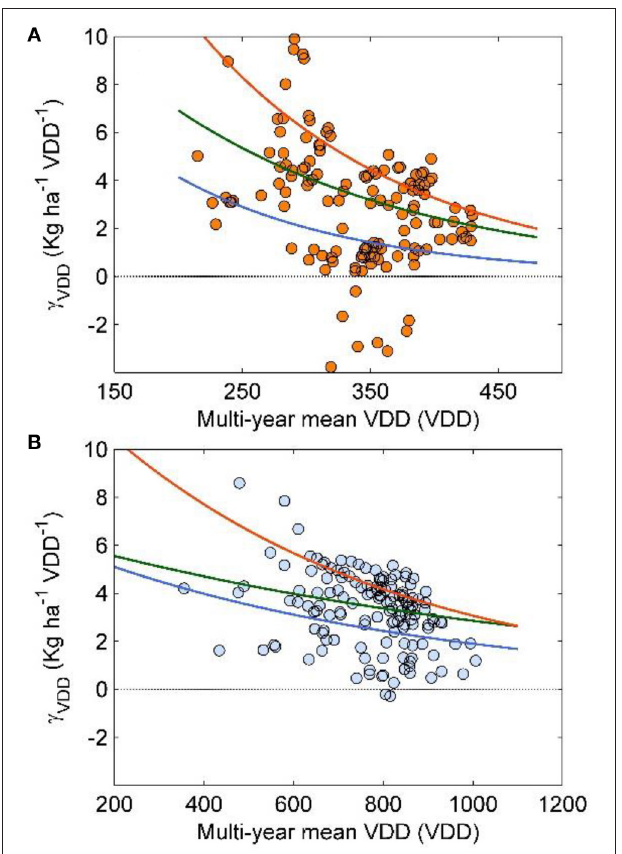
FIGURE 2 | Relationship between multi-year mean vernalization degree days (VDD) and the corresponding interannual sensitivity of winter wheat yields to VDD ( γ VDD ) during 1975–2009 in croplands of temperate Europe with significant fitted multivariate linear regressions. The orange and blue circles in (A,B) represent spatial relationship between γ VDD and multi-year mean VDD for two different VDD calculations based on function in SIMTAG and ORCHIDEE_crop, respectively, in grids with significant fitted multivariate linear regressions. The orange, dark green and blue lines in (A) are 75th, 50th, and 25th quantile negative exponential regression lines for the spatial relationships.